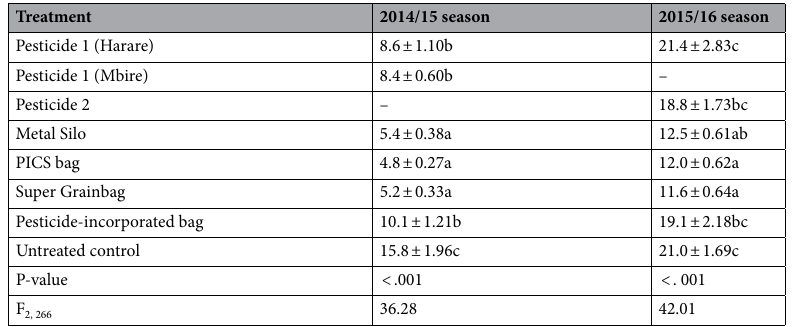
Table 2. Overall treatment effects on sorghum grain damage over the 32-week storage periods in Mbire district, Zimbabwe during the 2014/15 and 2015/16 storage seasons (n = 40). Means are compared per column and those which are followed by different letters are statistically different from one another using Tukey’s test at 0.05 level. ‘–’ indicates treatment was